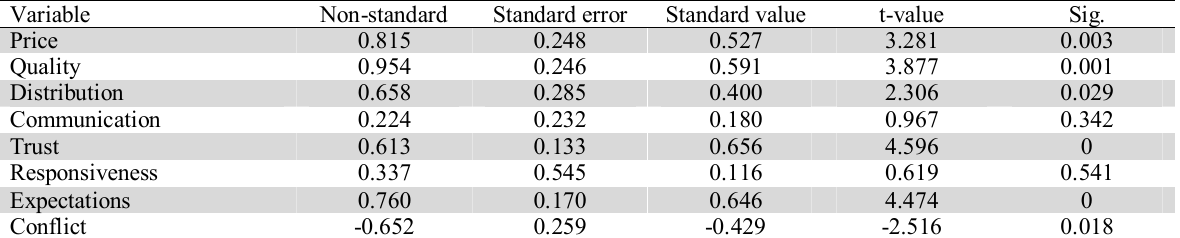
The summary of regression